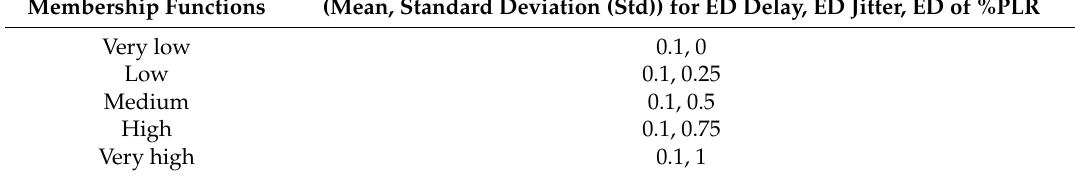
Table 1. Mean and standard deviation of the Gaussian fuzzy sets for inputs (Euclidian delay, Euclidian jitter, and Euclidian %PLR).